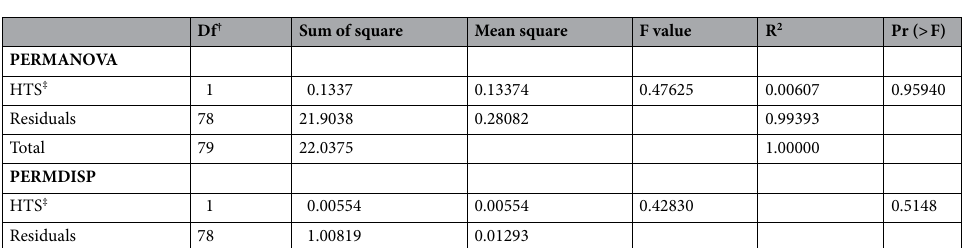
Table 3. Statistical results of Permutational Multivariate Analysis of Variance (PERMANOVA) and Permutational Multivariate Analysis of Dispersion (PERMDISP) for comparisons of species composition between iSeq and MiSeq. † Degree of Freedom (Df). ‡ High throughput sequencers (iSeq and MiSeq).